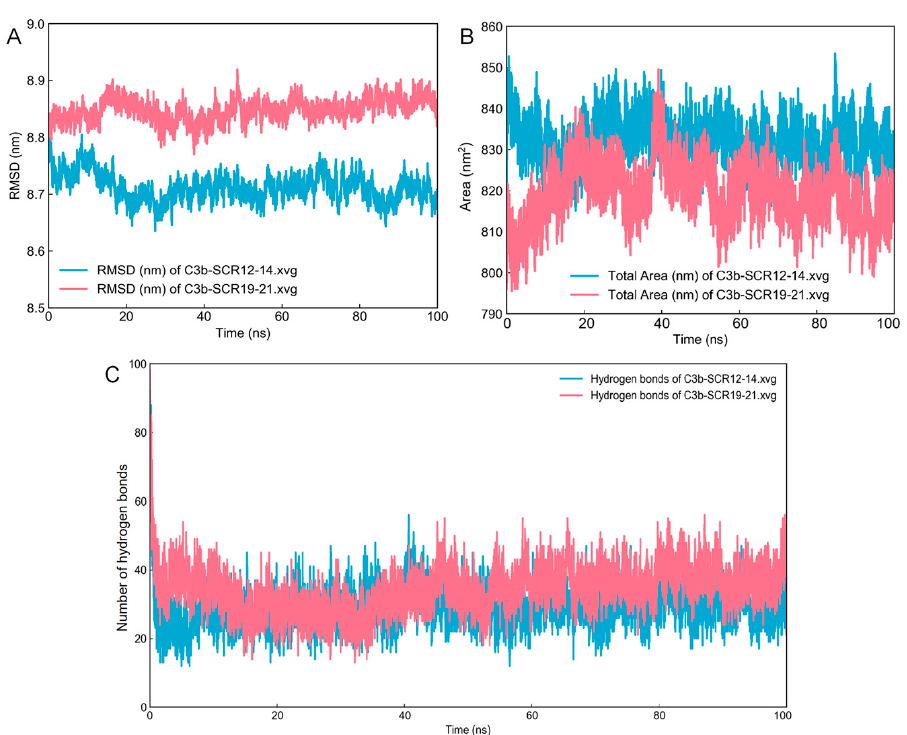
Figure 4. Molecular dynamics simulation of C3b–CR1-like complexes. (A) Backbone RMSD of C3b–